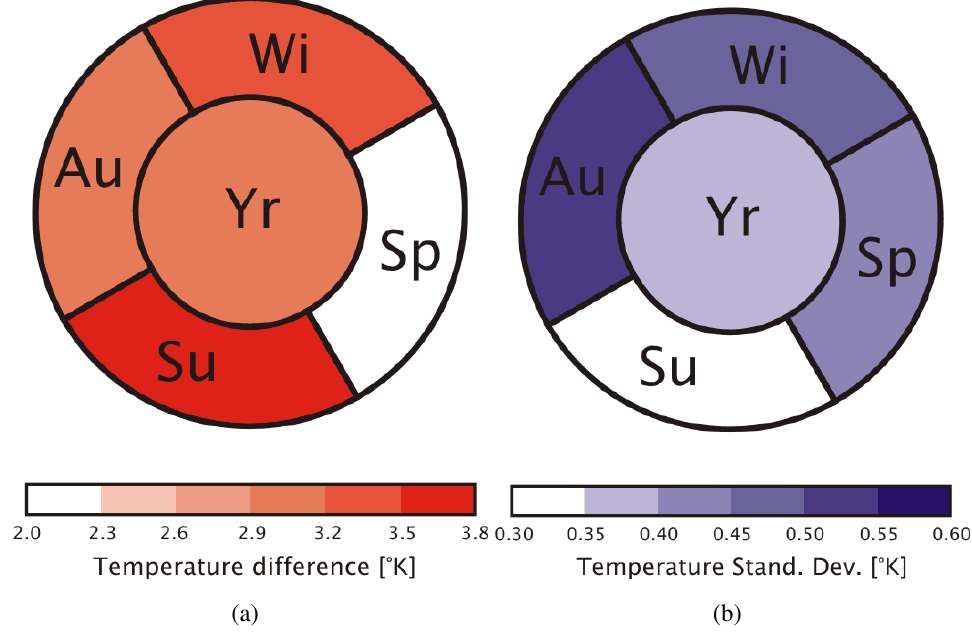
signals of the ensemble members that involve two- or three-tier model cascades. Time frame: Difference 2071–2100 (A1B) and 1971–2000 (20C). The central circle denotes the annual values and the ring segments around it are color coded according to the seasonal values for spring (Sp), summer (Su), autumn (Au) and winter